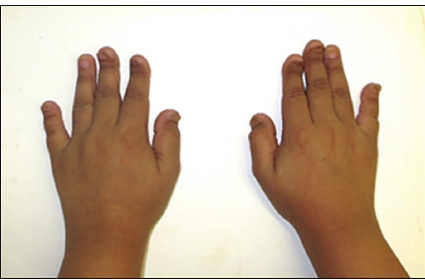
Figure 1: Broad hands with short, spoon shaped phalanges and dystrophic